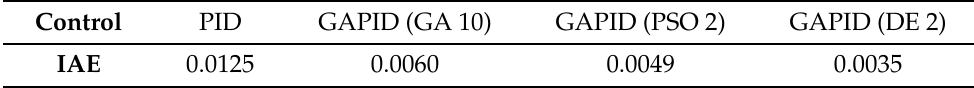
Table 3. IAE values of PID and